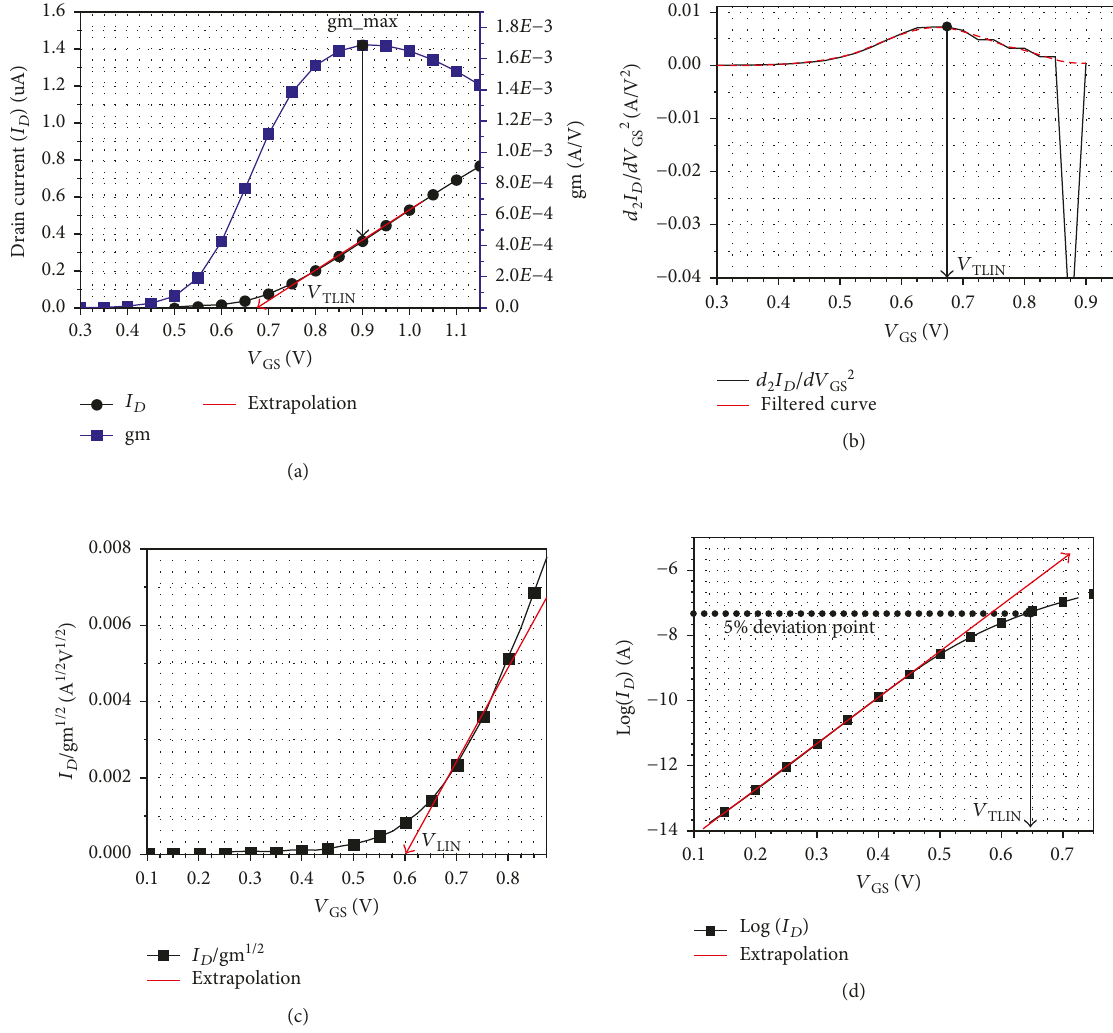
Figure 4: (a) Extraction of V TLIN using LEM for V DS (cid:2) 0.1 V. (b) Extraction of V TLIN using SDM for V DS (cid:2) 0.1 V. (c) Extraction of V TLIN using Ghibaudo method for V DS (cid:2) 0.1V. (d) Extraction of V TLIN using match point method for V DS (cid:2) 0.1V.